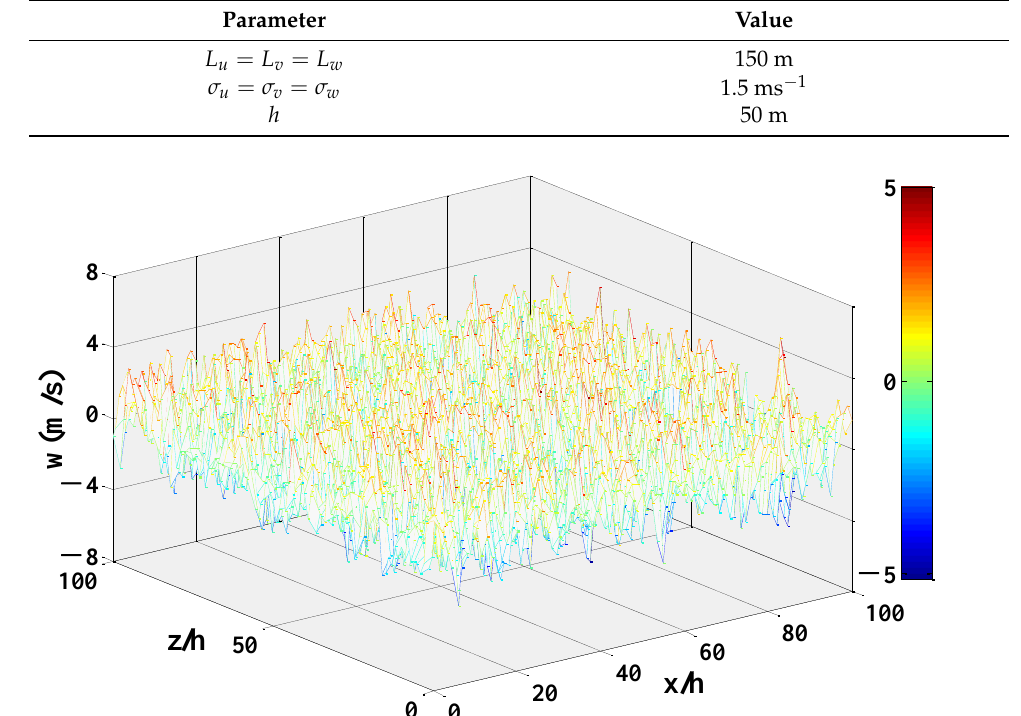
Figure 7. Atmospheric turbulent wind velocity in space (H = 600 m).